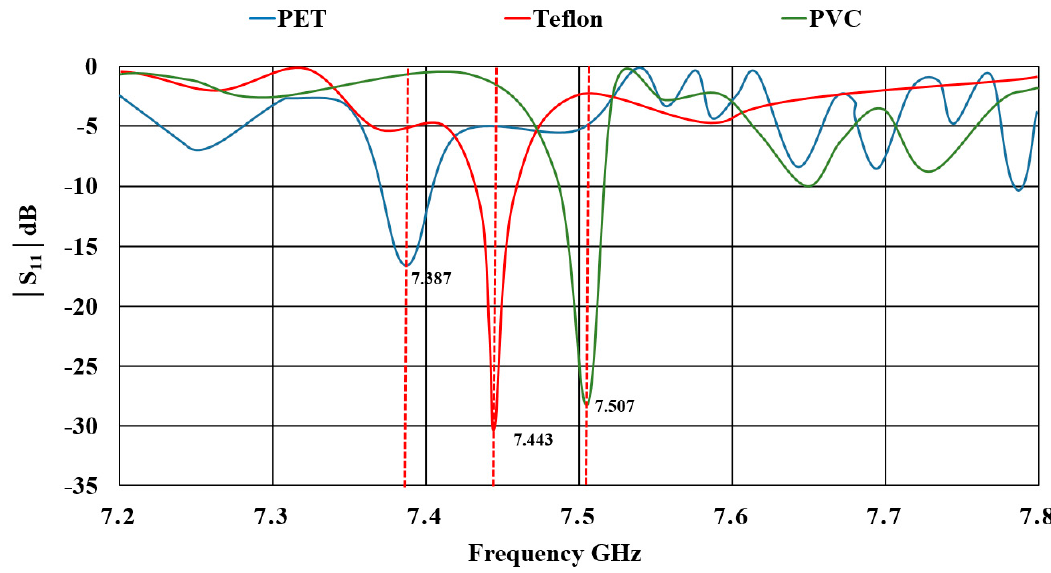
Figure 11. Reflection coefficients of E-shaped flexible polymer substrate antennas on PET, Teflon, and PVC substrates operating at 7.45 GHz.